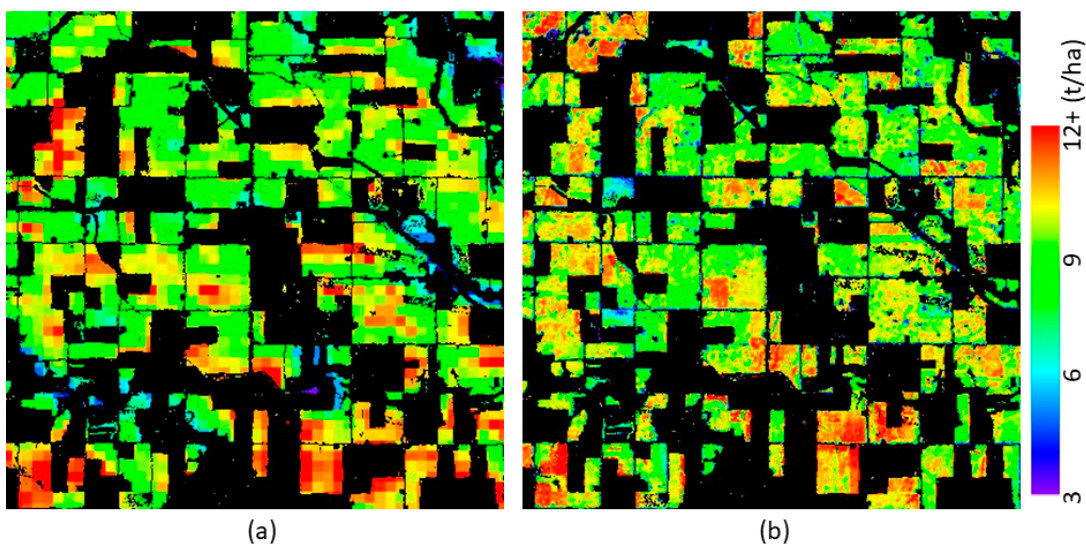
Figure 5. Corn yields estimated from MODIS ( a ) and the Landsat–MODIS data fusion results ( b ) using a simple linear model (Figure 4b) at the county level in 2010 for a subset area in Figure 1 (red box). The Cropland Data Layer (CDL) for 2010 was used to mask out non-corn classes (black).